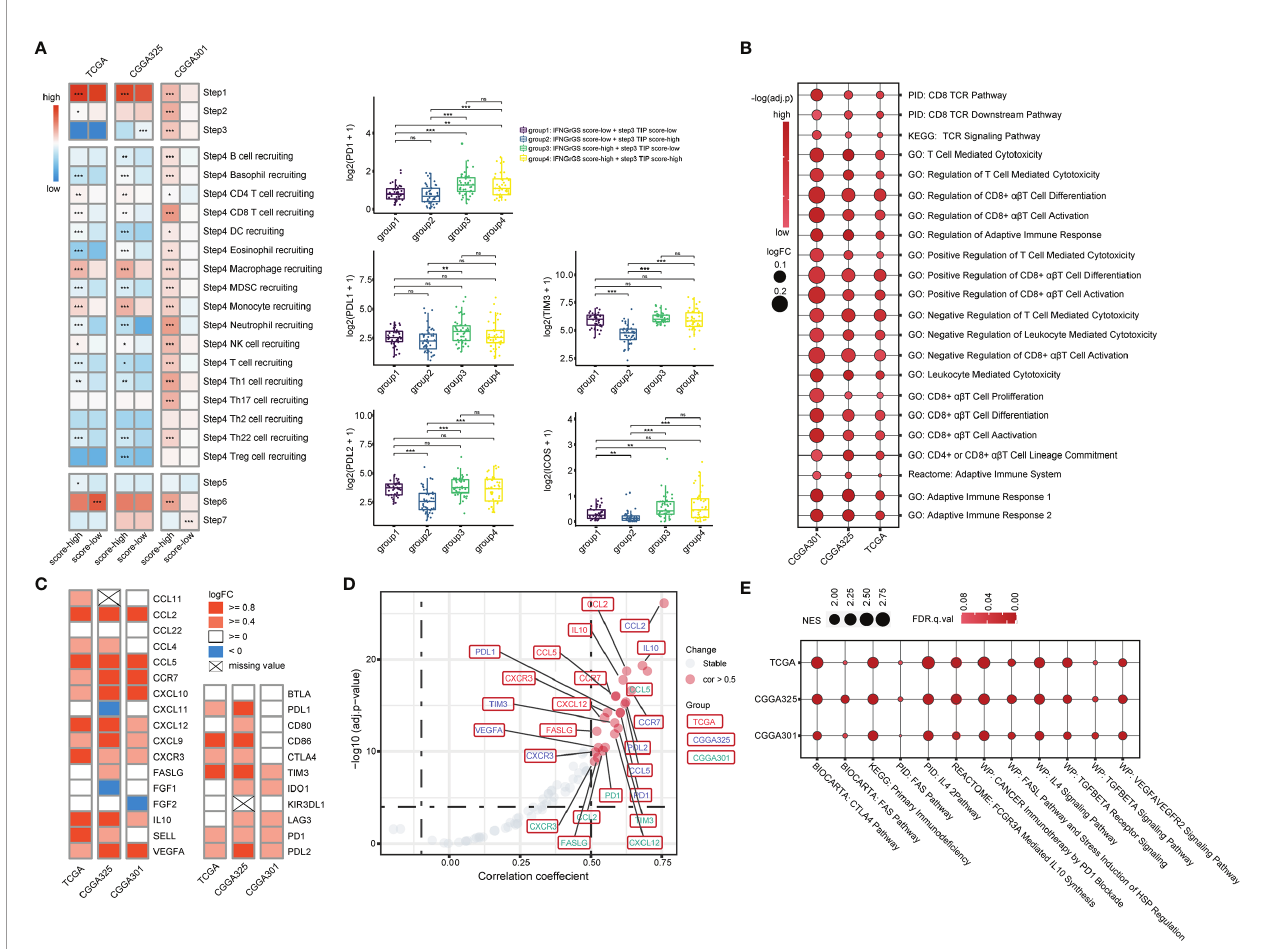
FIGURE 3 | Association between the IFNGrGS-based strati fi cation with the adaptive immune response. (A) The TIP system quantifying each step of the anti-tumor immune response. Color represents the average of the TIP score of the IFNGrGS score-high and -low groups. On the right panel, samples were further grouped according to the IFNGrGS score and TIP step3 score to compare the expression of common immune checkpoints (PD1, PDL1, PDL2, TIM3, and ICOS). (B) GSVA analysis of pathways involved in the adaptive immune response and CD8 T cell activation. The size of the bubble is proportional to the logFC value (IFNGrGS score- high vs. IFNGrGS score-low), color represents the adjust p-value. (C) The expression of 17 chemokines regulating the recruitment of the T lymphocyte and 11 co- inhibitory and co-stimulatory molecules regulating the function of T lymphocytes in the tumor niche. Color is proportional to the logFC value. (D) The correlation between the IFNGrGS score and the 28 molecules. The absolute value of correlation coef fi cient > 0.5 and adjust p-value < 0.05 were set as the cut-off. (E) The NES values of immunosuppressive pathways including TGF-beta, VEGFA, IL4, IL10, FAS, PD1, CTLA4, and primary immunode fi ciency pathway calculated by GSEA analysis. The size of the bubble is proportional to the NES. Color represents the FDR-q value. *p < 0.05, **p < 0.01, ***p < 0.001, and ns, non-signi fi